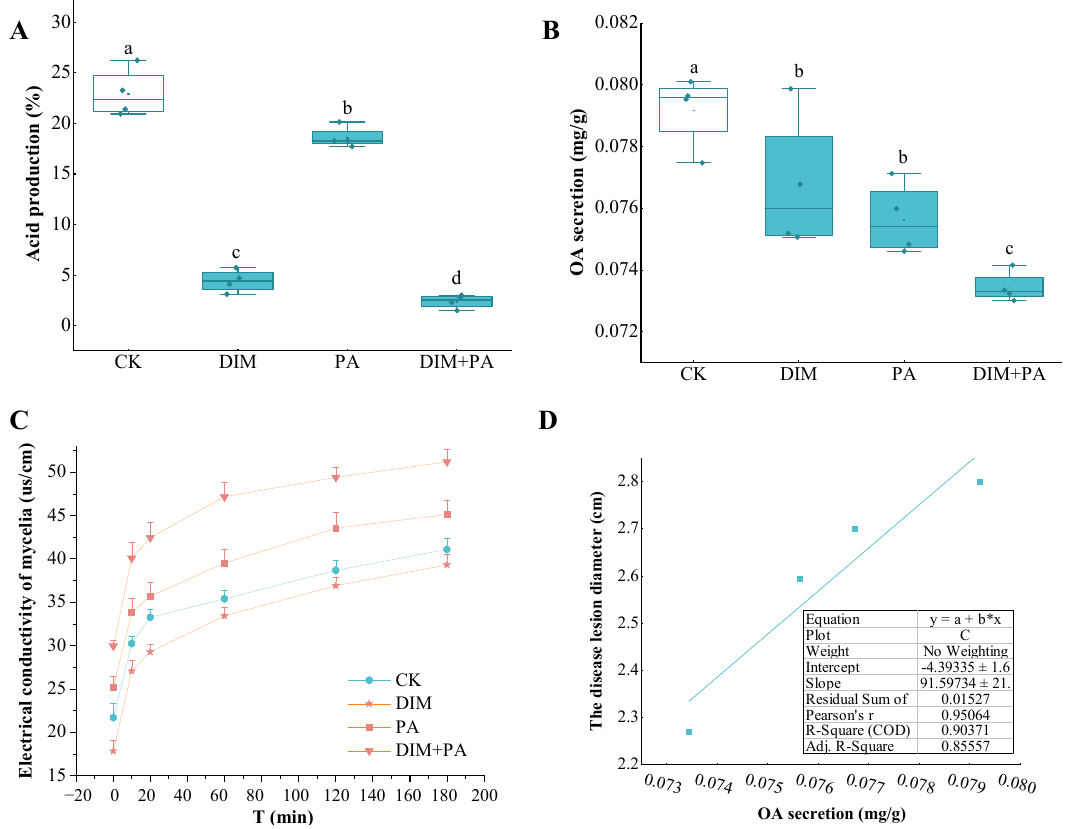
Figure 6. Effect of Se on the physiological property of S. sclerotiorum mycelia. The treatments were: CK, DIM (0.8 mg·L − 1 ), PA (0.1 mg·mL − 1 ), and DIM (0.8 mg·L − 1 ) + PA (0.1 mg·mL − 1 ), respectively. ( A ) The electrical conductivity of S. sclerotiorum mycelia. ( B ) Acid production of S. sclerotiorum mycelia. ( C ) OA secretion of S. sclerotiorum mycelia. ( D ) The correlation between OA secretion and the disease lesion diameter. Vertical bars indicate standard deviations (SD). Different letters (a, b, c, d) indicate statistically significant differences among the different treatments ( p < 0.05).